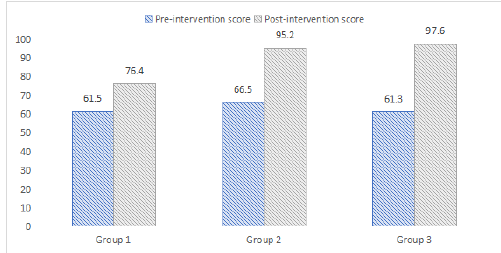
Figure 2. Graphical comparison of foot and ankle disability